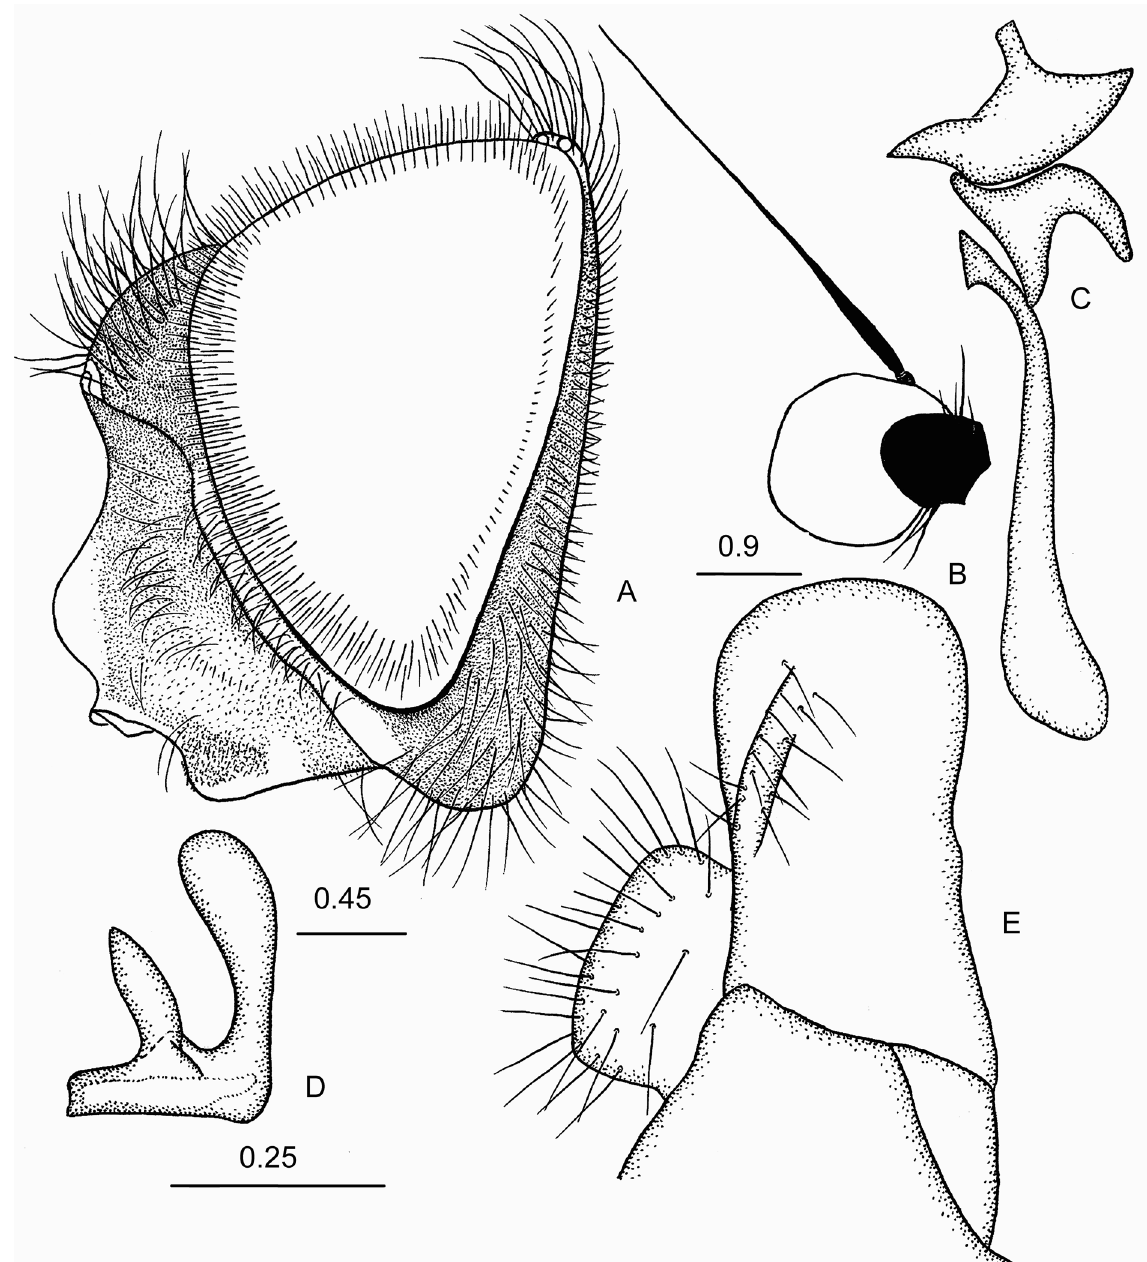
Fig. 24. Cheilosia ( Montanocheila ) gilva sp. nov., holotype, ♂ (CSCA). A . Head, lateral view. B . Antenna, lateral view of pedicel and basoflagellomere. C . Aedeagus and aedeagal apodeme, lateral view. D . Superior lobe of hypandrium, lateral view. E . Surstylus and gonocercus, lateral view. Scale bars indicated in